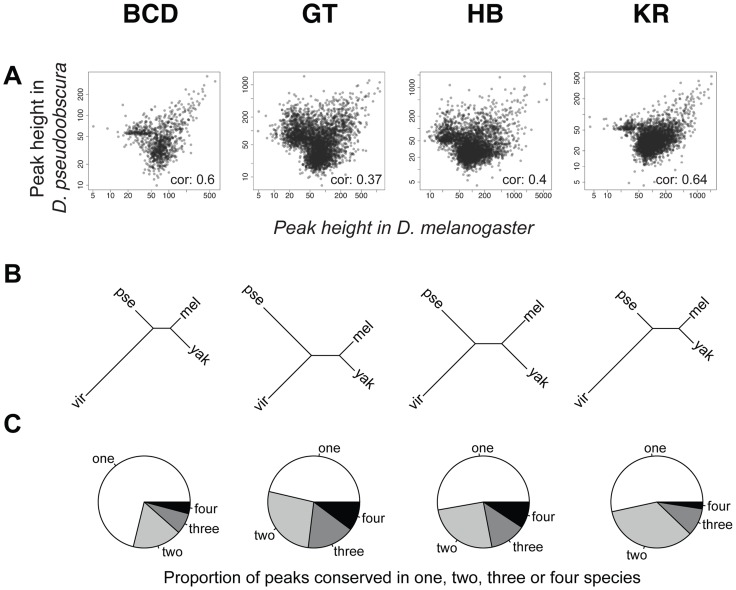
Comparison of BCD, GT, HB and KR binding in D.melanogaster, D.yakuba, D.pseudoobscura and D.virilis.
A. Pair-wise comparisons of BCD, GT, HB or KR binding between D. melanogaster and D. pseudoobscura. Spearman's correlation coefficients are indicated. All correlations were highly significant (p-values<2.10−16). See Figure S4 for all pair-wise comparisons. B. Neighbor-joining trees based on pairwise distance matrices of TF occupancy at bound loci. C. Proportion of the number of species for which TF was detected per cluster, from a species-specific peak (“one”), to a peak conserved in all 4 species (“four”). For simplicity, the species names were shortened using their first three letters: D.melanogaster (mel), D.yakuba (yak), D.pseudoobscura (pse) and D.virilis (vir).